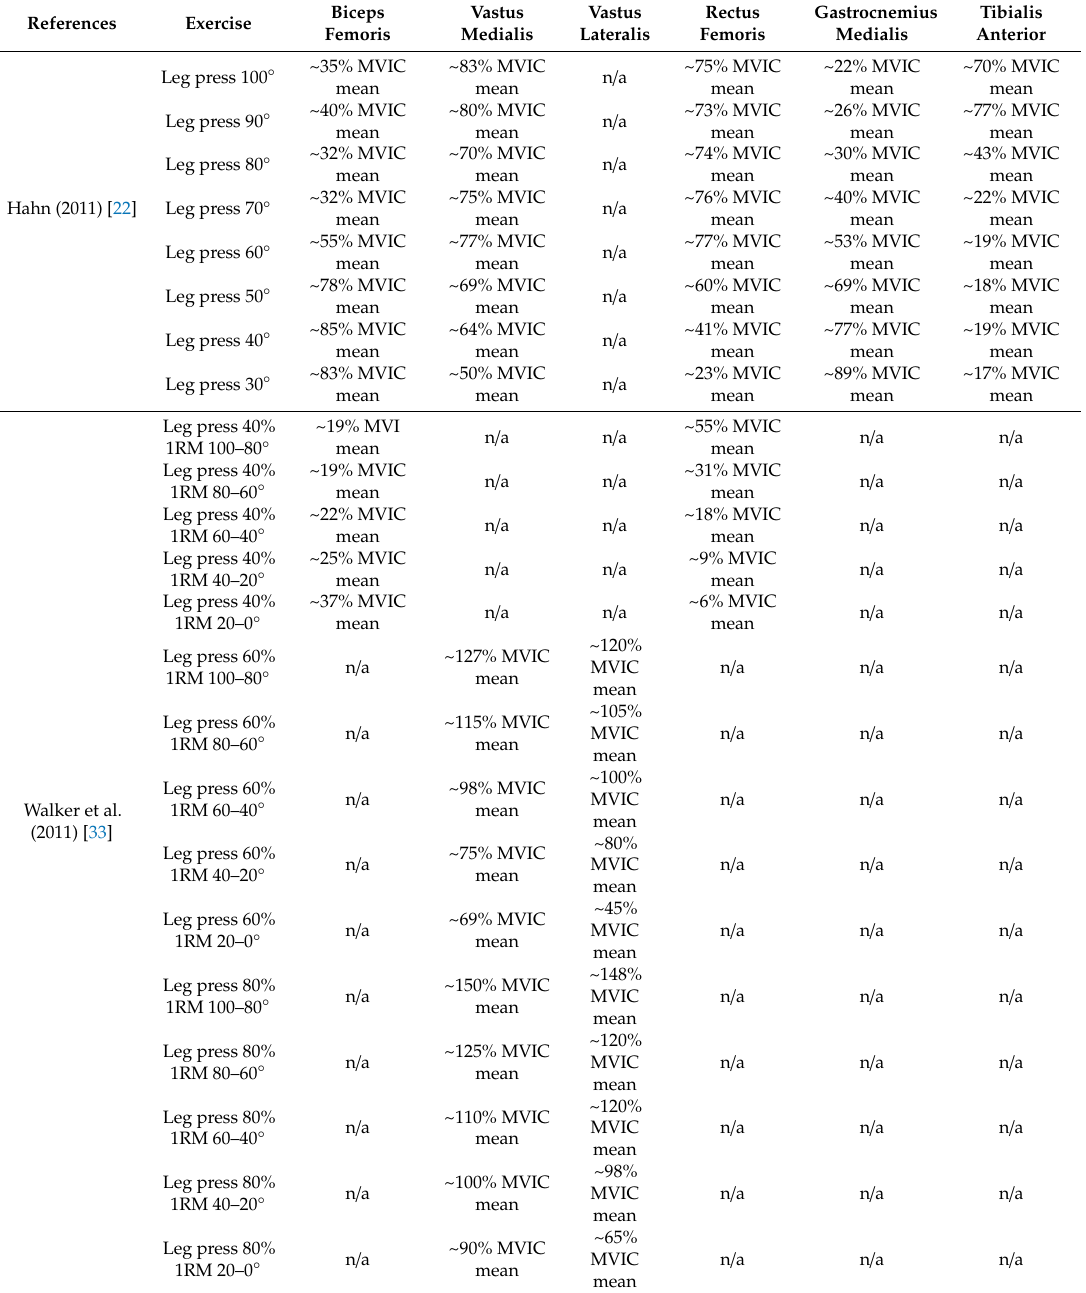
Table 2. Data on sEMG activity for studies assessing the leg